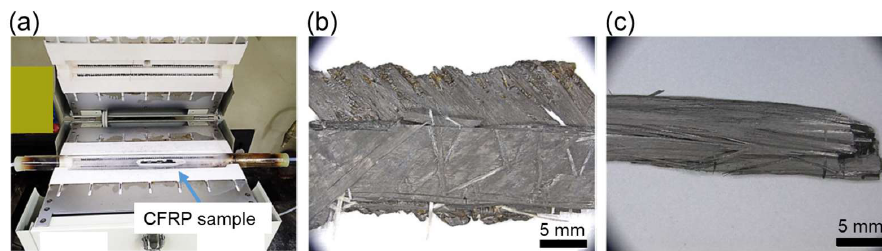
Figure A1. ( a ) Tubular furnace for the heat treatment of CFRP under 800 °C for 5 h supplied with 1 L/min of N 2 gas, and the picture of CFRP specimen ( b ) before heat treatment and ( c ) after heat treatment.